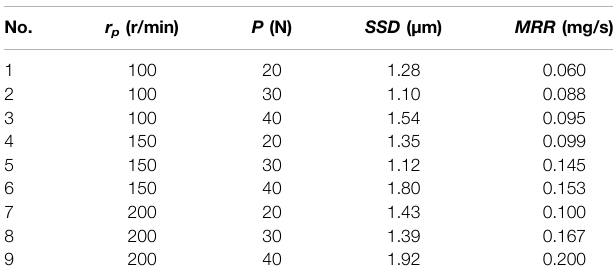
TABLE 1 | Experimental results in the lapping